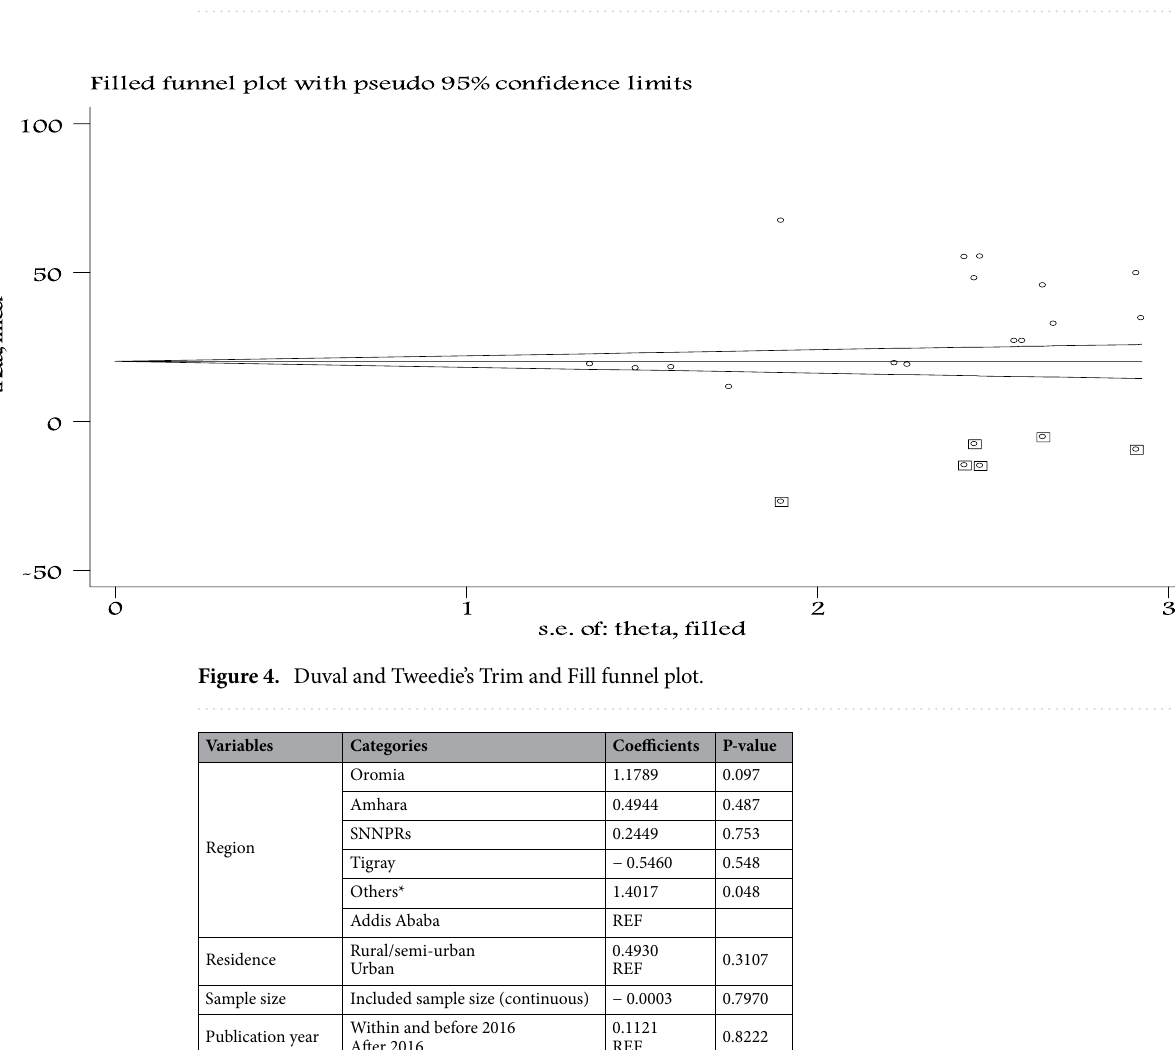
Table 2. Egger’s test result to assess publication bias.